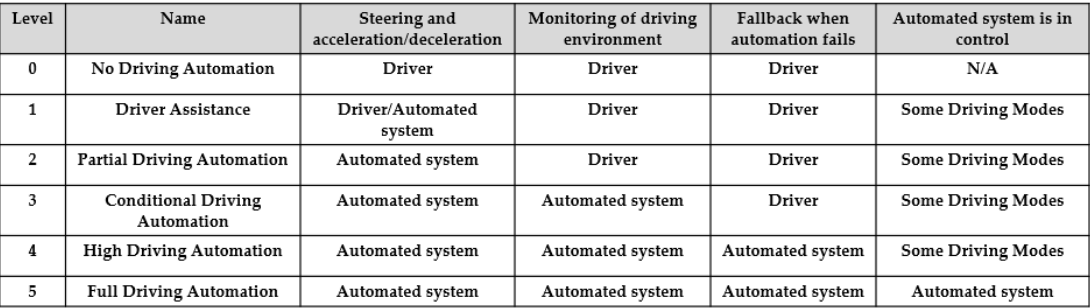
Figure 4. The 5 levels of driving automation [13].